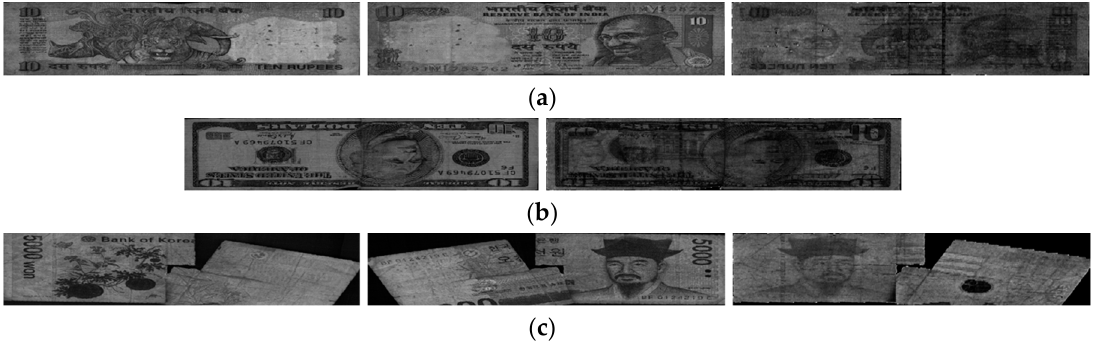
Figure 12. Examples of error cases in the testing of our proposed method: ( a ) Case 1—unfit banknote